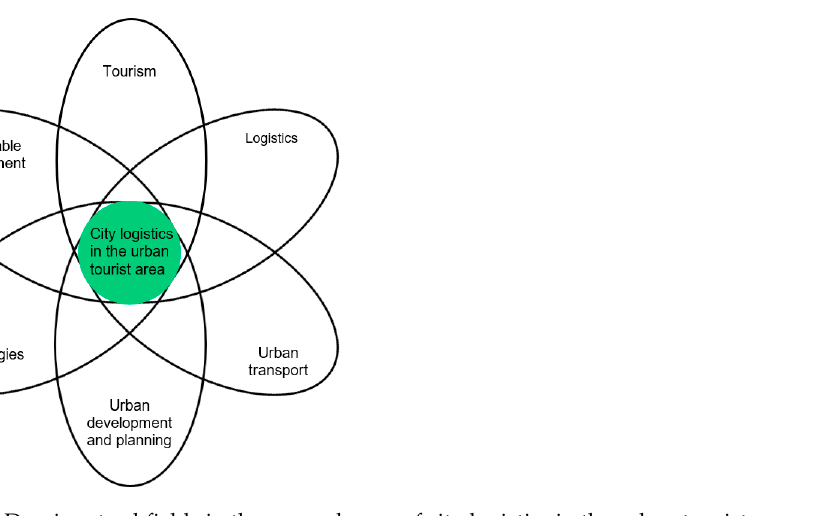
Figure 4. Map of links between the analysed keywords, broken down by the mean year of publica ‐ tion release. Source: Own elaboration using the VOSviewer software. The dominant subfields in the research area of city logistics in the urban tourist area are shown in Figure 5.